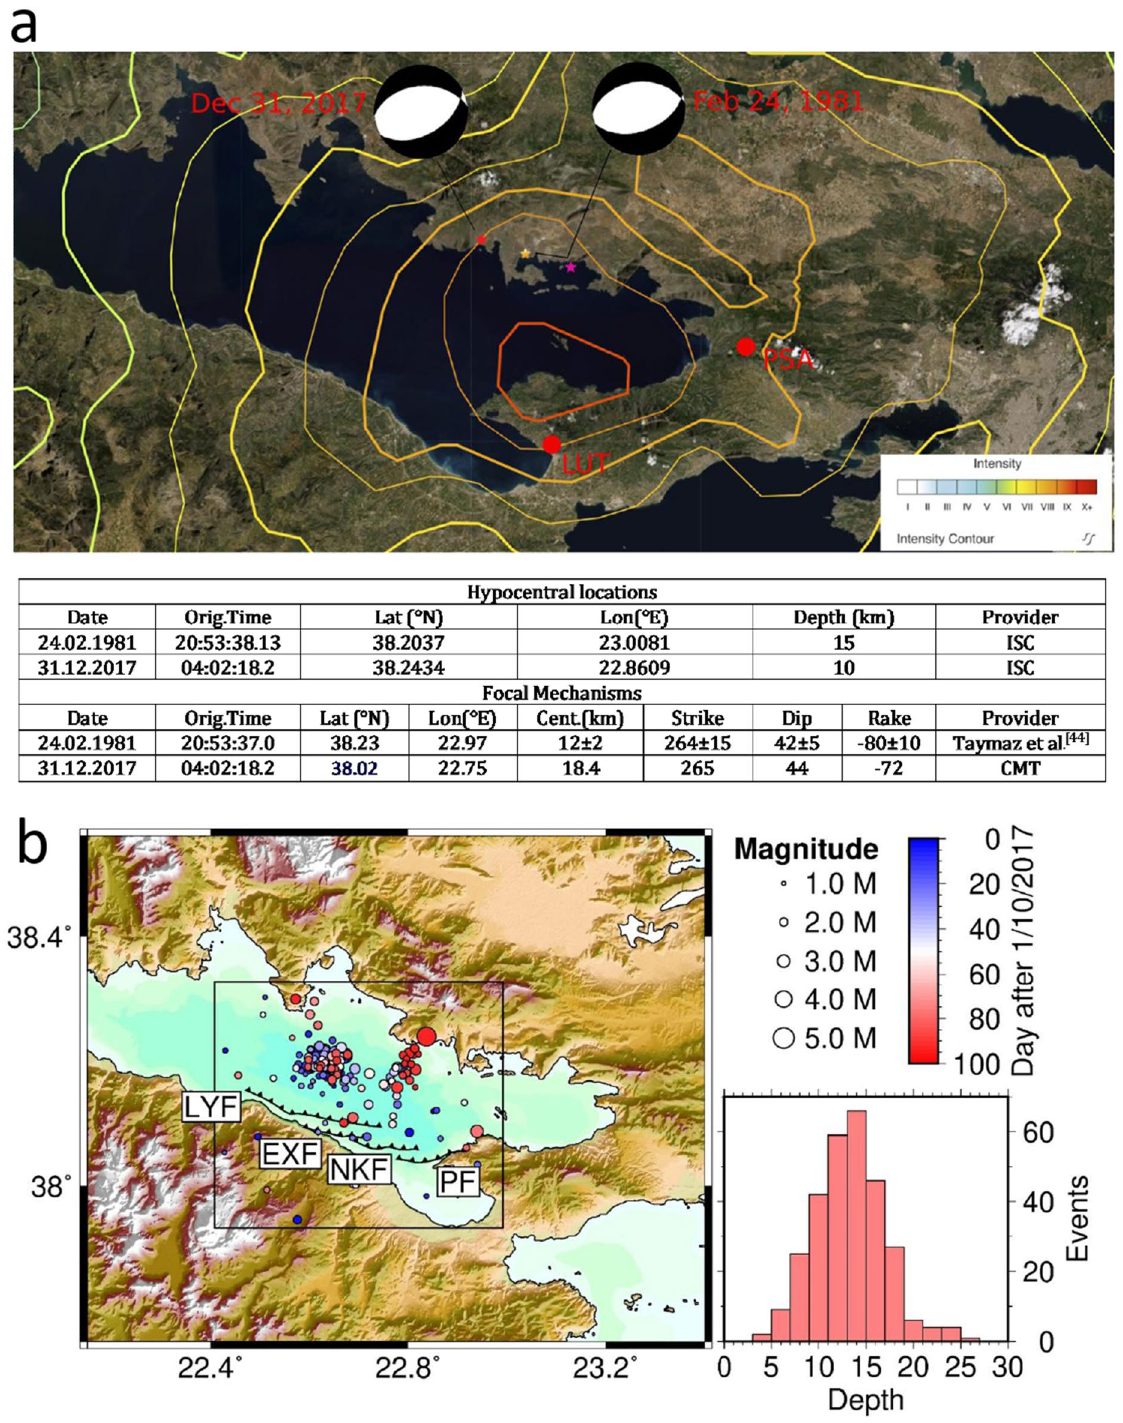
Figure 3. ( a ) The epicenter of Mw4.9 earthquake on Dec.31, 2017 (red star—ISC) was almost at the same place with the Mw6.6 catastrophic event of Feb. 24, 1981 (yellow star—USGS and purple star-ISC solution). The focal mechanisms were also absolutely similar. The two solutions are shown in the embedded table below. Both solutions are compatible with the same large faults that exist at south coast of the gulf. The image also depicts the Feb 24, 1981 earthquake intensity based on the Modified Mercalli Intensity Scale as calculated by USGS 45 . LUT station is in a very close proximity to the fault that is probably associated with the two events. ( b ) The seismic activity for the period between Oct. 1–Dec. 31, 2017, before the strong Mw4.9 event of Dec. 31, 2017, can be related with the activation of the low angle faults of the southern coast of the Gulf of